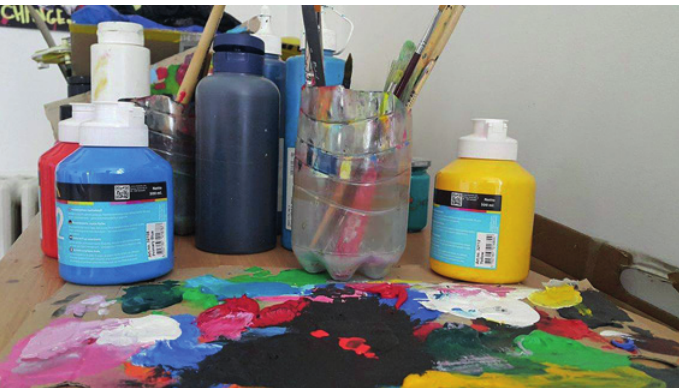
Figure 2. Artist’s working materials (source: photo was taken by author during the field work in one of the painters art